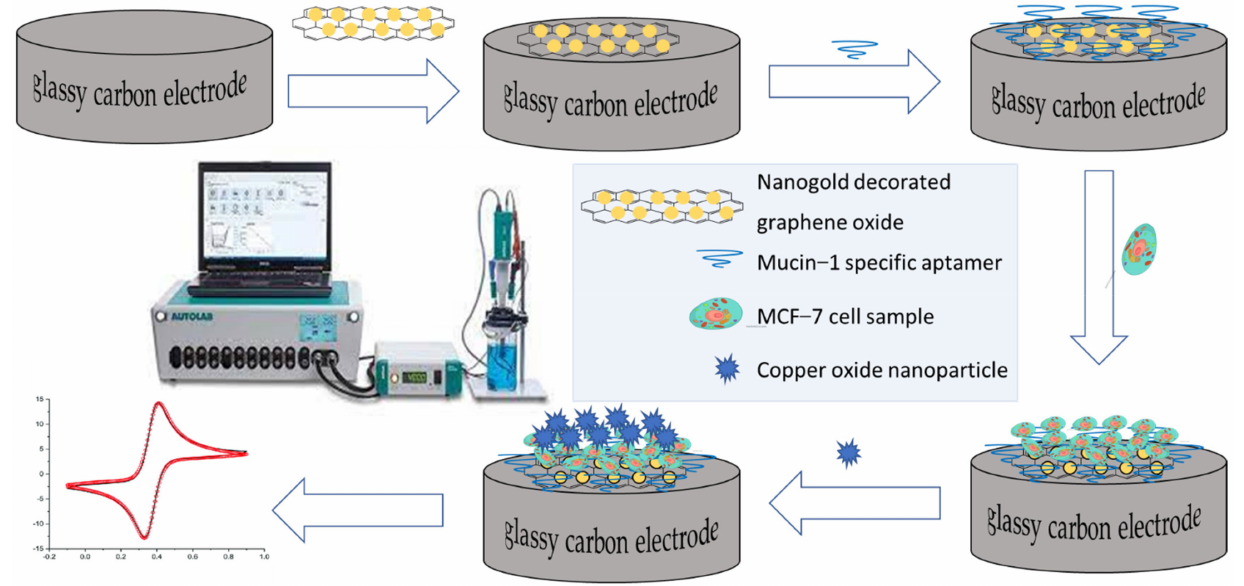
Figure 7. Illustration of the cyclic voltametric detection of circulating MCF-7 cells by means of a copper oxide nanozyme supported on a nanocomposite consisting of graphene oxide decorated with gold